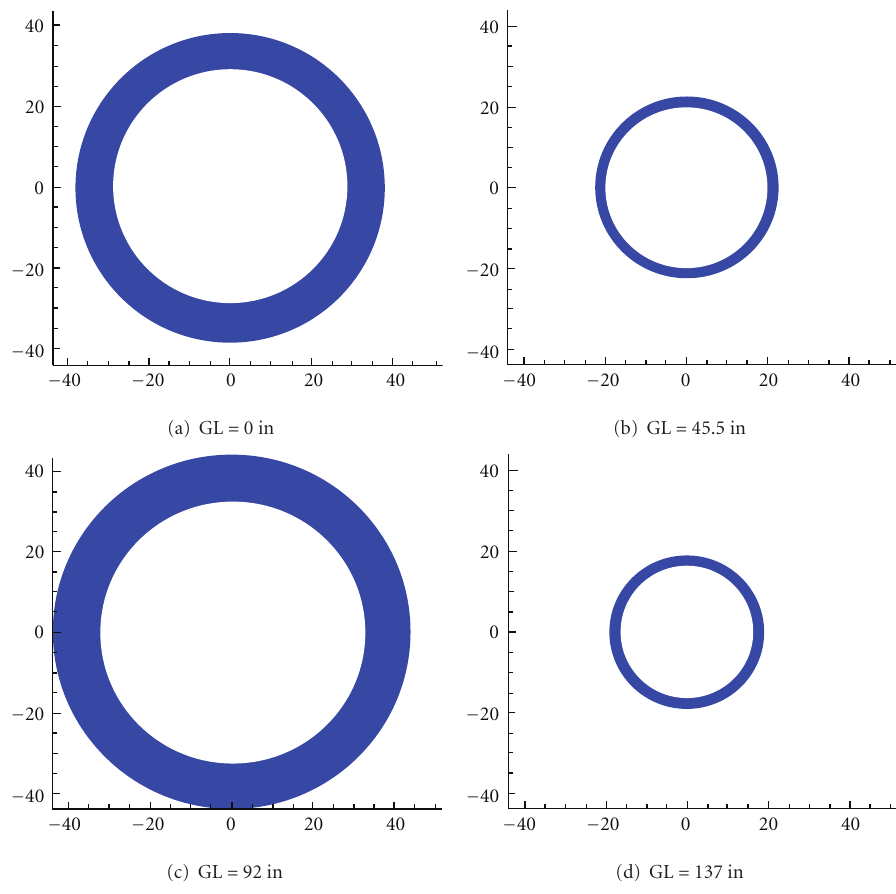
Figure 15: Optimized grain cross section for linearly regressive CP